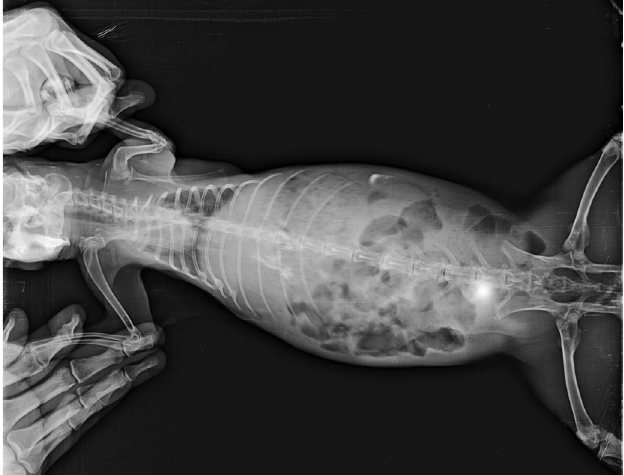
FIGURE 9 - X-ray image of formulation containing HPMC E5LV with barium sulphate after eight